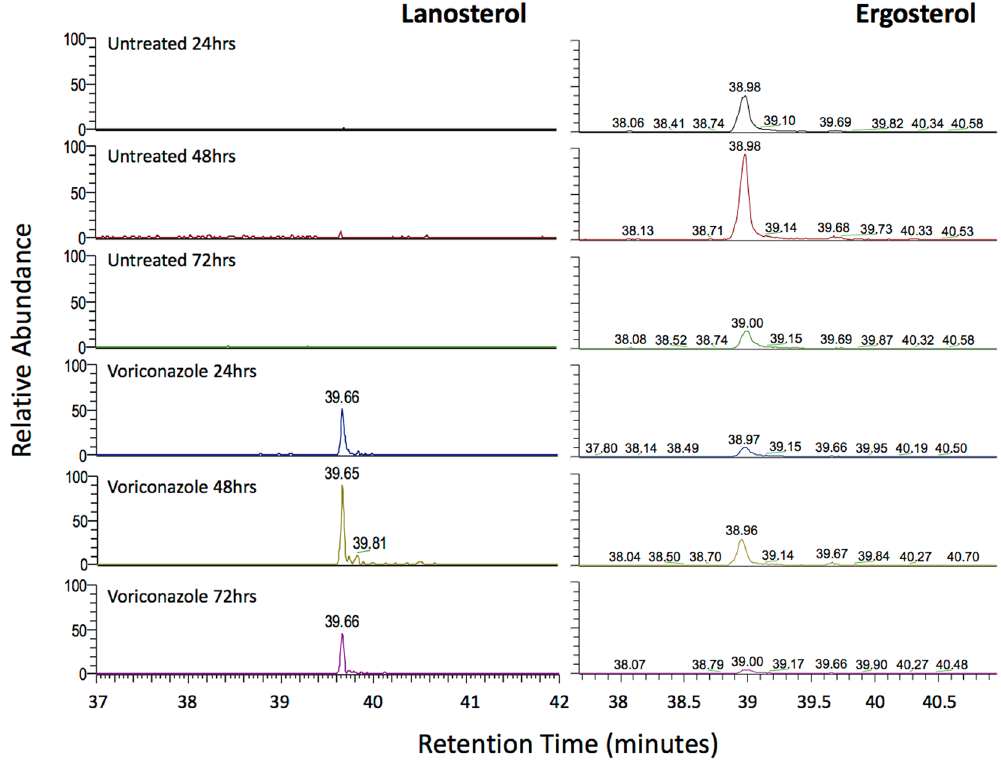
Figure 4. Extracted ion chromatograms for lanosterol ( m/z = 426.38, RT = 39.66 min) and ergosterol ( m/z = 396.33, RT = 38.98 min) at 24, 48, and 72 hours before and after treatment with